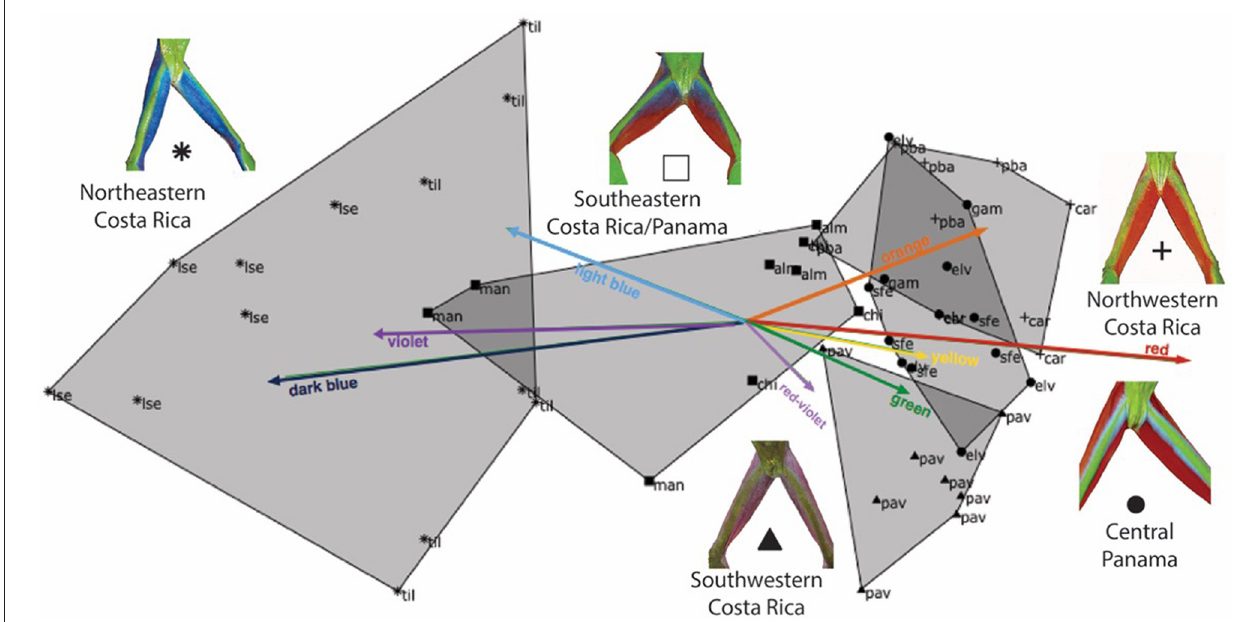
FIGURE 5 | Ordination biplot illustrating the peptide profiles of 54 individual frogs and eight explanatory co-variates divided into color-bins (orange, red, yellow, green, red-violet, violet, dark blue, and light blue). Each point represents an individual’s peptide profile, identified to population (three-letter abbreviation) within one of five geographic regions (shaded hulls). Arrows indicate the direction and magnitude of the color hue component associated with peptide presence. The first two axes of the CCA together explain 55.71% of the peptide variation.